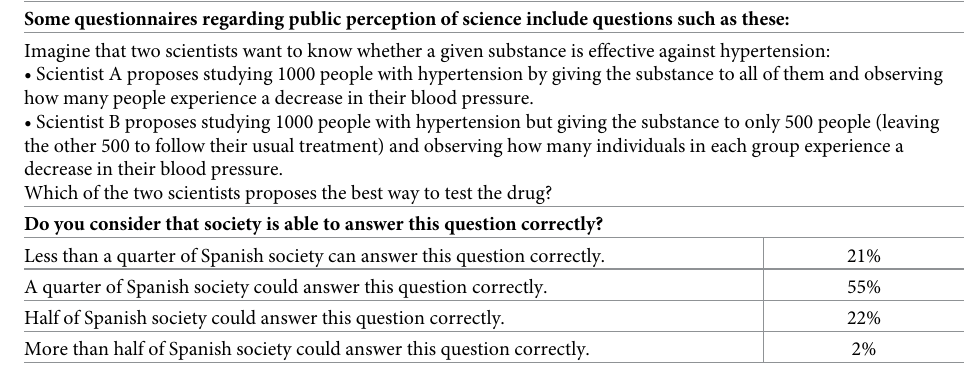
Table 6. Scientists’ views of public understanding of a scientific process (role of a clinical trial). Some questionnaires regarding public perception of science include questions such as